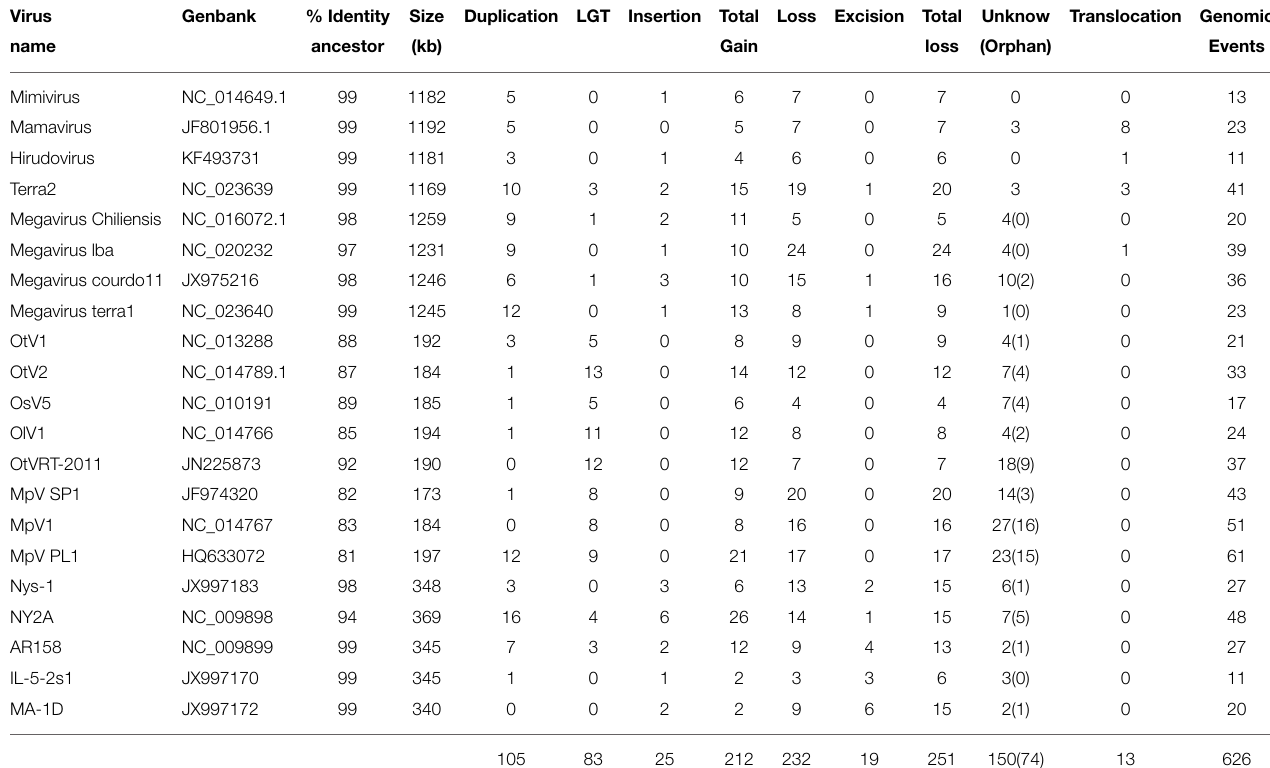
TABLE 1 | Major characteritics of GV genomes and description of the genomic events that have occured after the divergence with their respective common ancestors. Virus